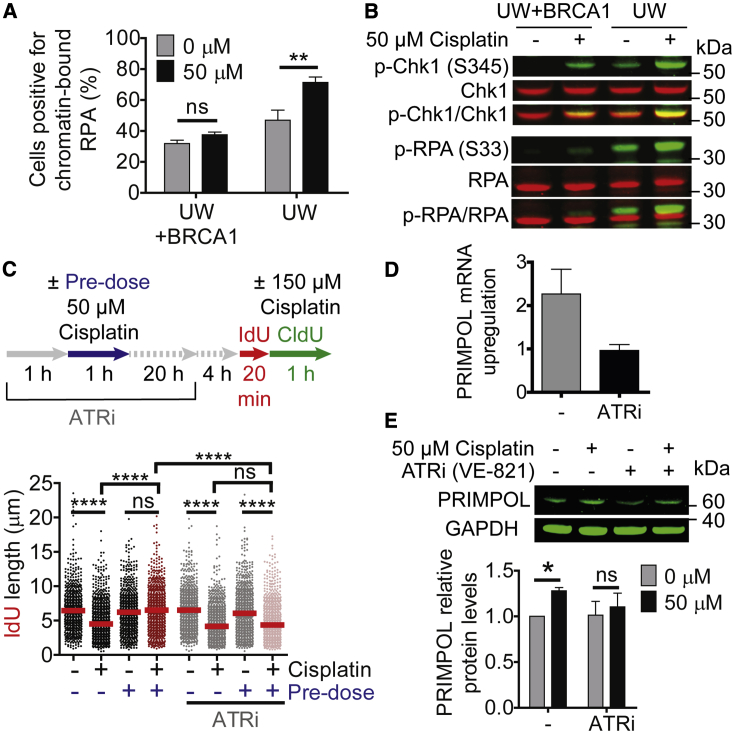
ATR Activity Controls PRIMPOL-Mediated Adaptive Response(A) Percentage of UW+BRCA1 and UW cells positive for chromatin-bound RPA detected by flow cytometry 24 h after treatment with 0 or 50 μM cisplatin. Means ± SEM (n = 3). Statistics: two-way ANOVA followed by Bonferroni test. ns, non-significant, ∗∗p < 0.01.(B) p-Chk1 (S345, green), total Chk1 (red), p-RPA32 (S33, green), and total RPA (red) expression in UW+BRCA1 and UW cells 24 h upon 0 or 50 μM cisplatin. Simultaneous detection of phosphorylated form and total protein bands is shown in p-Chk1/Chk1 and p-RPA/RPA. A western blot representative of three independent experiments is shown.(C) Schematic for the DNA fiber assay with the ATR inhibitor (ATRi) VE-821. 62.5 nM VE-821 was added 1 h prior to treatment with the pre-dose and removed from the media 4 h before performing the DNA fiber assay (top). Dot plot and median of IdU tract lengths in UW cells ± 150 μM cisplatin ± pre-dose ± ATRi (bottom) (n = 3). ns, non-significant, ∗∗∗∗p < 0.0001.(D and E) PRIMPOL mRNA (D) and protein (E) levels 24 h upon 0 or 50 μM cisplatin (pre-dose) ± ATRi. (D) Means ± SEM. Three independent biological replicates are shown and presented as fold change between 50 μM cisplatin and untreated samples. Representative western blot (E, top) and quantification (E, bottom) from four independent experiments. Statistics: two-way ANOVA followed by Bonferroni test. ns, non-significant, ∗p < 0.05.See also Figure S3.